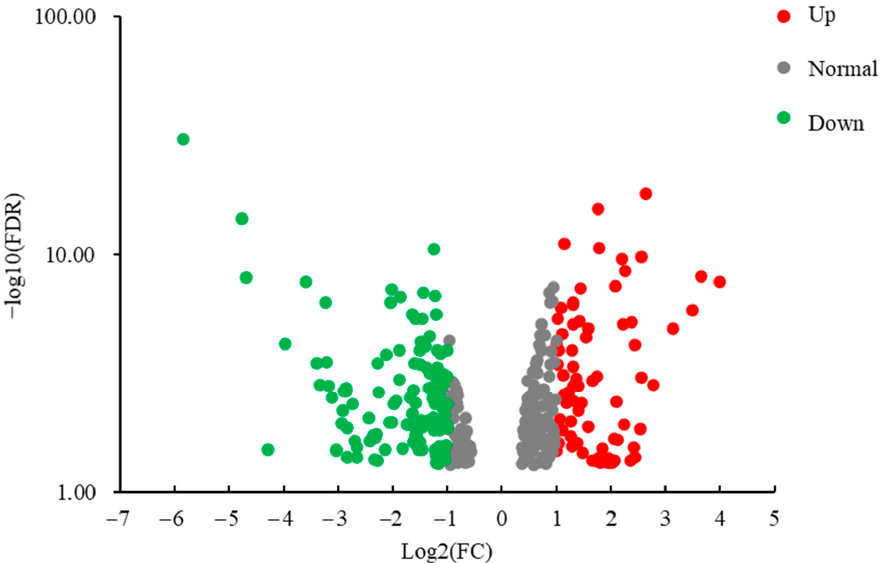
Animals 2021 , 11 , x FOR PEER REVIEW Figure 3. Volcano figure of RNA-seq (BP vs. CP; CP: cross-bred commercial pigs, BP: Large Black pigs; Up: up-regulated in BP compared with CP; Normal: no significant differences; Down: down-regulated in BP compared with CP).